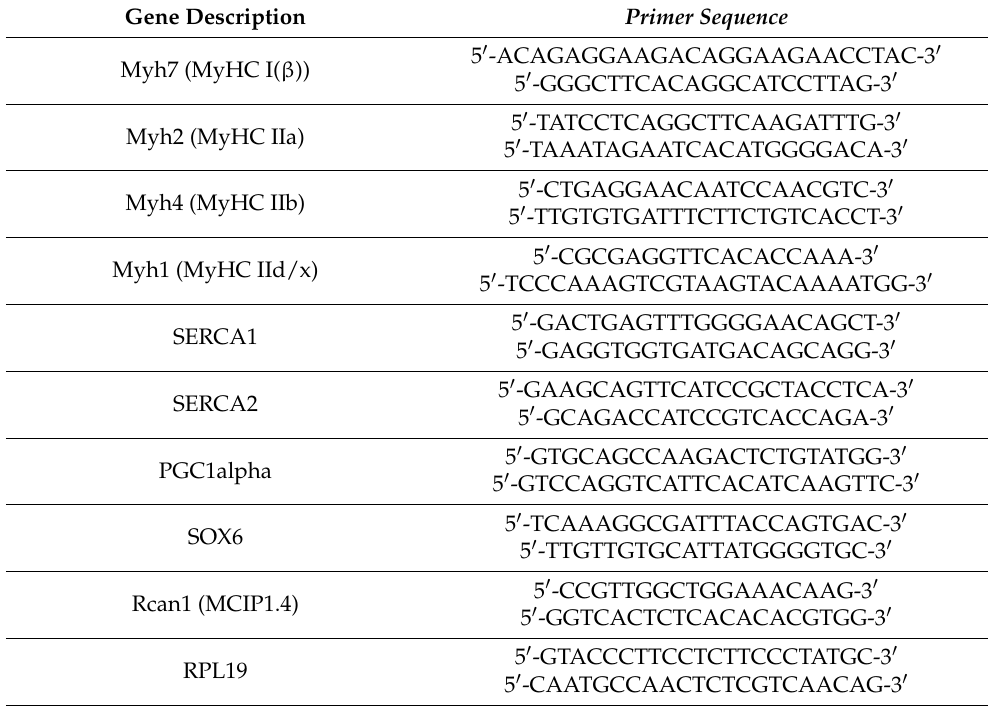
Table 2. PCR primers used in the